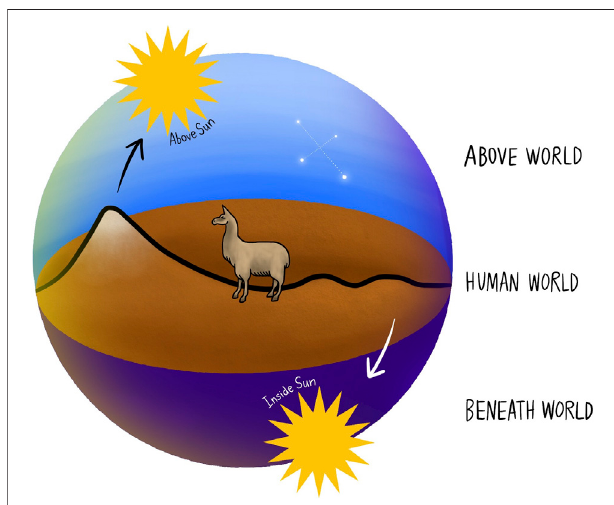
FIGURE1| Lickanantayorganizationofthethreeworlds.Design:Sergio